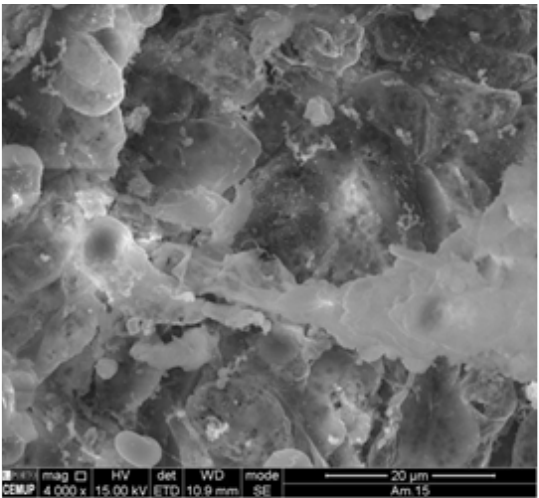
Figure 2A. Secondary Electron Image from Renal Tumor Tissue. Magnification at 4000x.